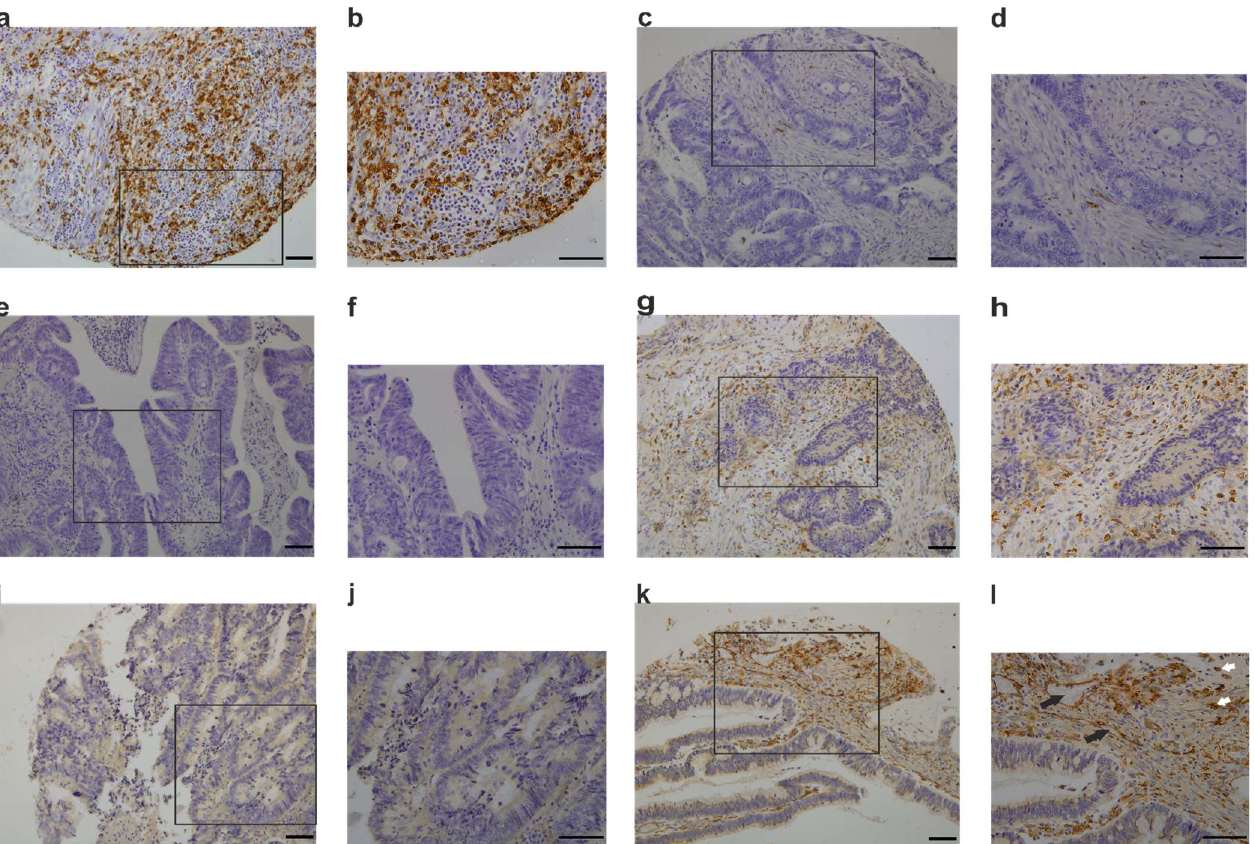
Figure 3. Immunohistochemical stainings of CLEVER-1 + /CD68 + macrophages and CLEVER-1 + lymphatic vessels in intra- tumoral stage I–IV colorectal cancer (CRC) samples. ( a , b ) High CD68 + macrophage number. ( c , d ) CRC sample with a low CD68 + macrophage number. ( e , f ) CRC sample lacking CD68 + macrophages. ( g , h ) High CLEVER-1 + macrophage number. ( i , j ) Sample lacking CLEVER-1 + macrophages. ( k , l ) CRC sample with high amount of both CLEVER-1 + macrophages and vessels. Black arrows indicate vessels, white arrows indicate macrophages. Magnification × 10 in ( a , c , e , g , i , k ) magnification × 20 in insets ( b , d , f , h , j , l ). Scale bars 100 µ m in all figures.